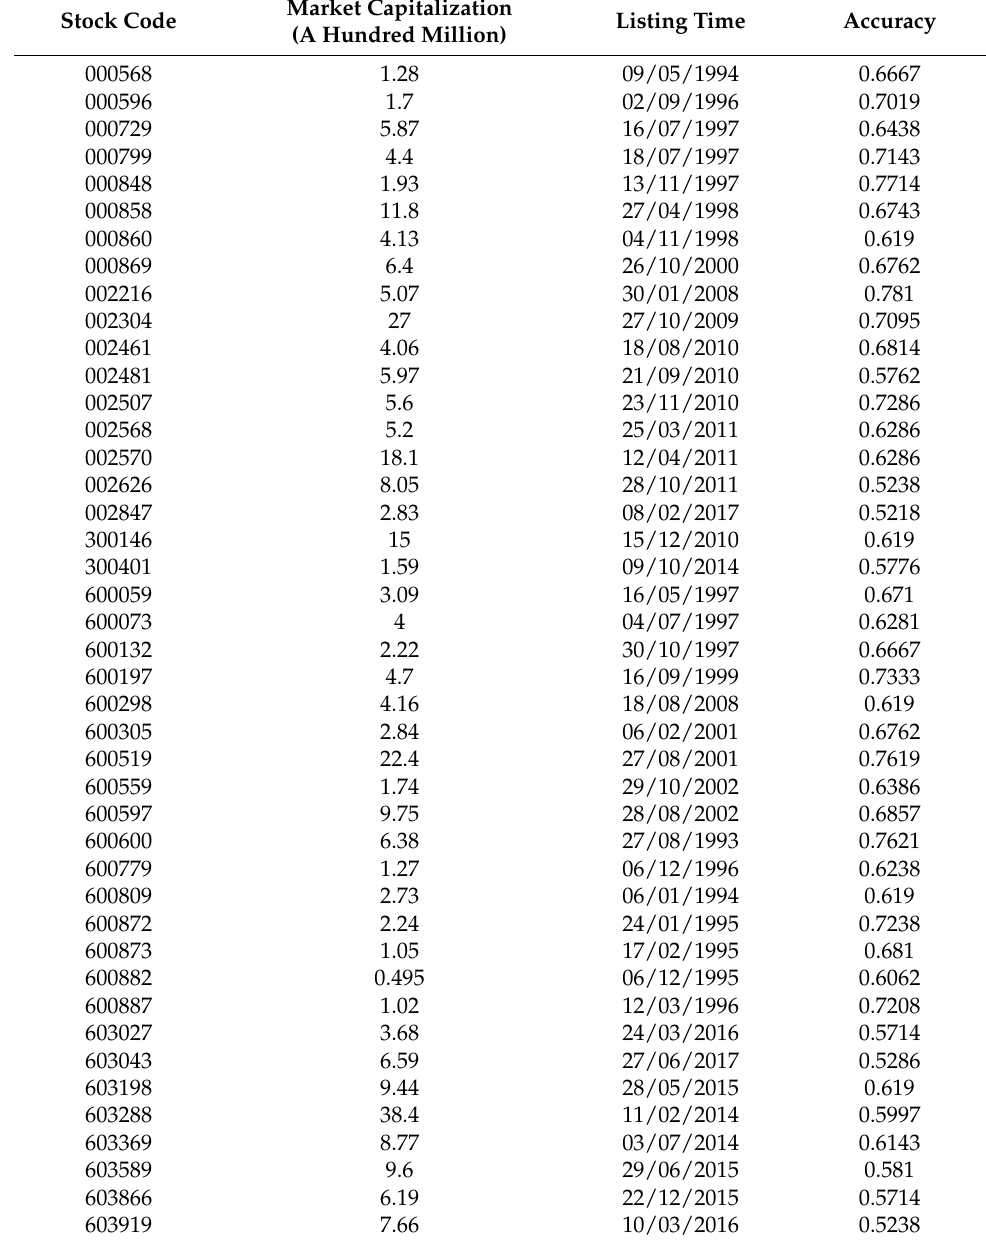
Table A2. Prediction accuracy of constituent stocks in Food and Beaverage sub-industry Index